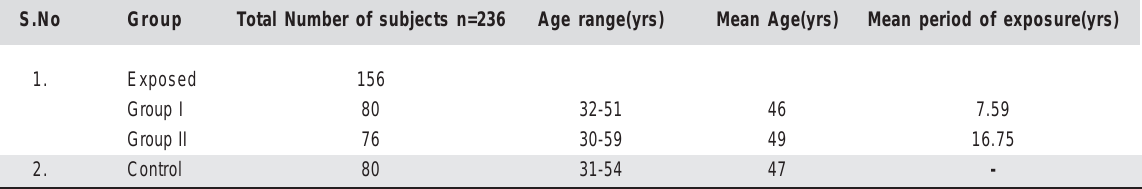
Table 1 - Characterization of the participants